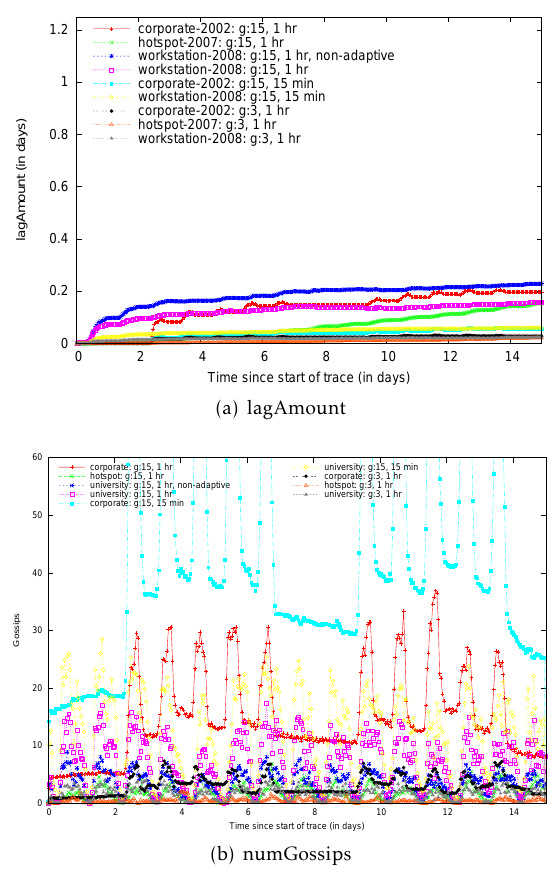
Figure 16. Svr-NodeInit policy leverages the availability of server nodes and propagates its updates quickly. Fig. 16(a) shows that even after fifteen days, the lagAmount was a modest 0.2 days (this value can be as high as 1.2 days for the other propagation mechanisms). Summary. We investigated the performance bounds of a best policy that instantaneously propagated the